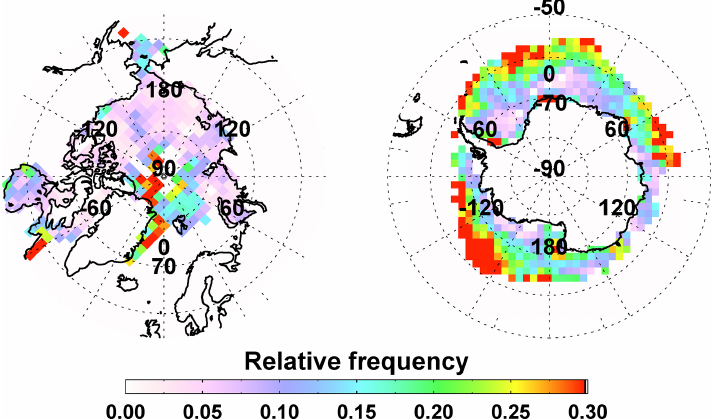
Figure 12. Spatial distributions of the relative frequency of high wind speeds during the enhanced BrO occurrences in the Arctic ( v ≥ 12ms − 1 ) and Antarctic ( v ≥ 14ms − 1 ) sea ice regions in spring (Arctic: March to April; Antarctic: September to October).